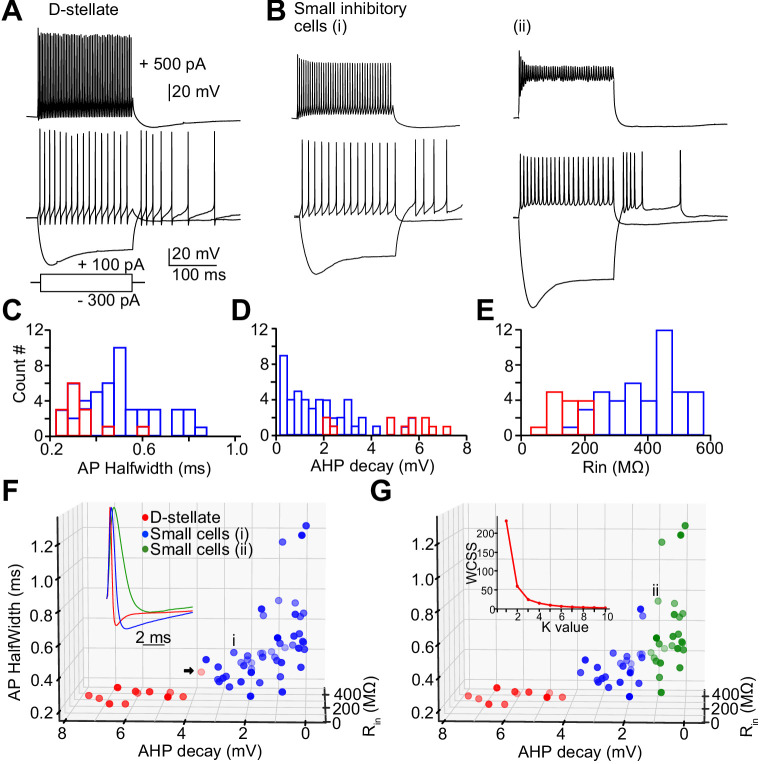
Heterogeneity of spiking properties of the small glycinergic cells.Representative examples of D-stellate cells (A) and small glycinergic cell types (B) responding to current injections (+500 pA, +100 pA, and −300 pA). All cells showed sustained firing responses to +100 pA current injections. Small cells exhibited diverse spike amplitude adaptation in responses to strong (+500 pA) current steps (top, Bi-ii). (C–E) Histogram of AP halfwidth, AHP decay, and Rin (F) Classification of glycinergic cells based on the AP halfwidth, AHP decay, and Rin. The elbow method was used to calculate the optimal number of clusters (Panel 6G, inset [labels, Within cluster sum of squares (WCSS)]). Glycinergic cells are group into clusters based on K-means cluster analysis (K = 2) (red: D-stellate cells, blue: small cells, color gradient: front [dark] to back [light]). (G) K = 3 resulted in further classification of small cells into two sub clusters (blue and green). Arrow points to the D-stellate cell included in small cells when K = 3, i and ii represents small cells in blue and green clusters, respectively. Source data is available at https://doi.org/10.5061/dryad.69p8cz8xp. The spreadsheet Figure_6-Source_Data_1_intrinsic_properties.xlsx contains all the raw data used for the quantitative analyses shown in Figure 6.